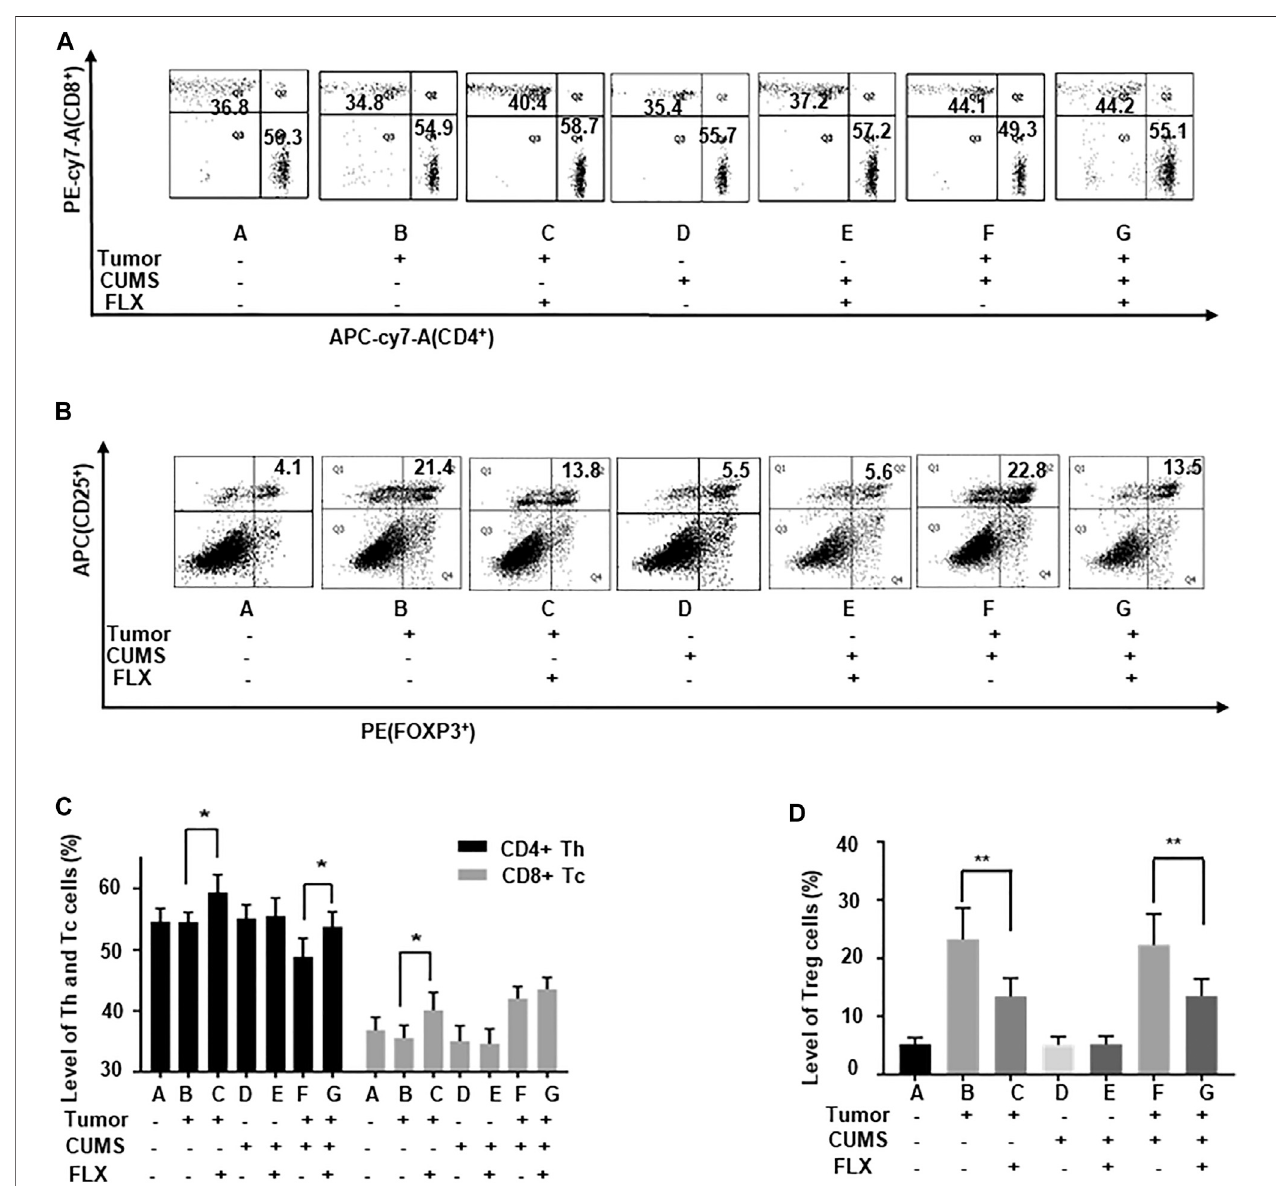
FIGURE 5 | The number of Th, Tc, and Treg cells in the peripheral blood of mice. (A,C) The percentages of Th and Tc cells. (B,D) The percentages of Treg cells. Data were expressed as mean ± SD. * p < 0.05, ** p < 0.01.